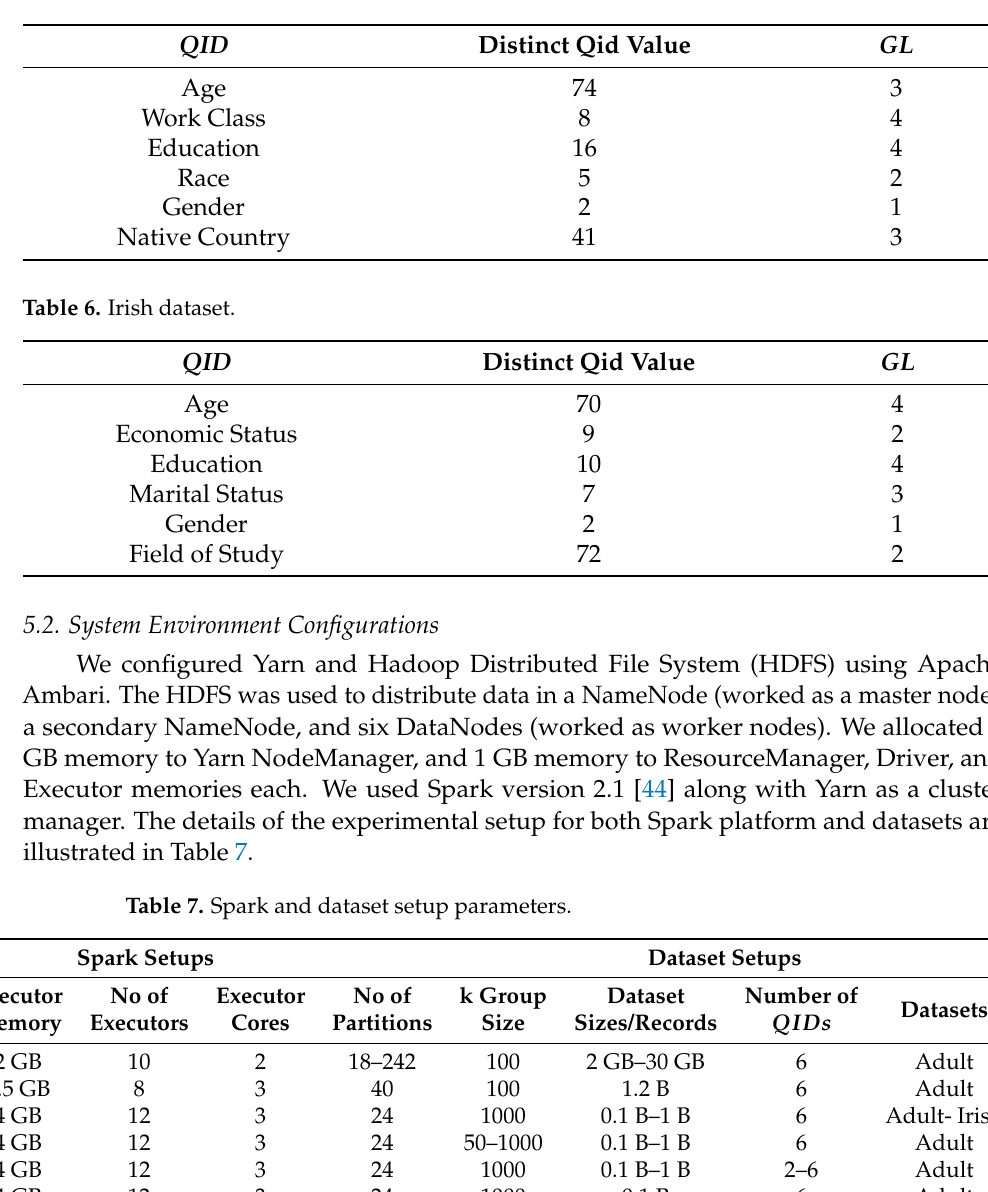
Table 5. Adult dataset.